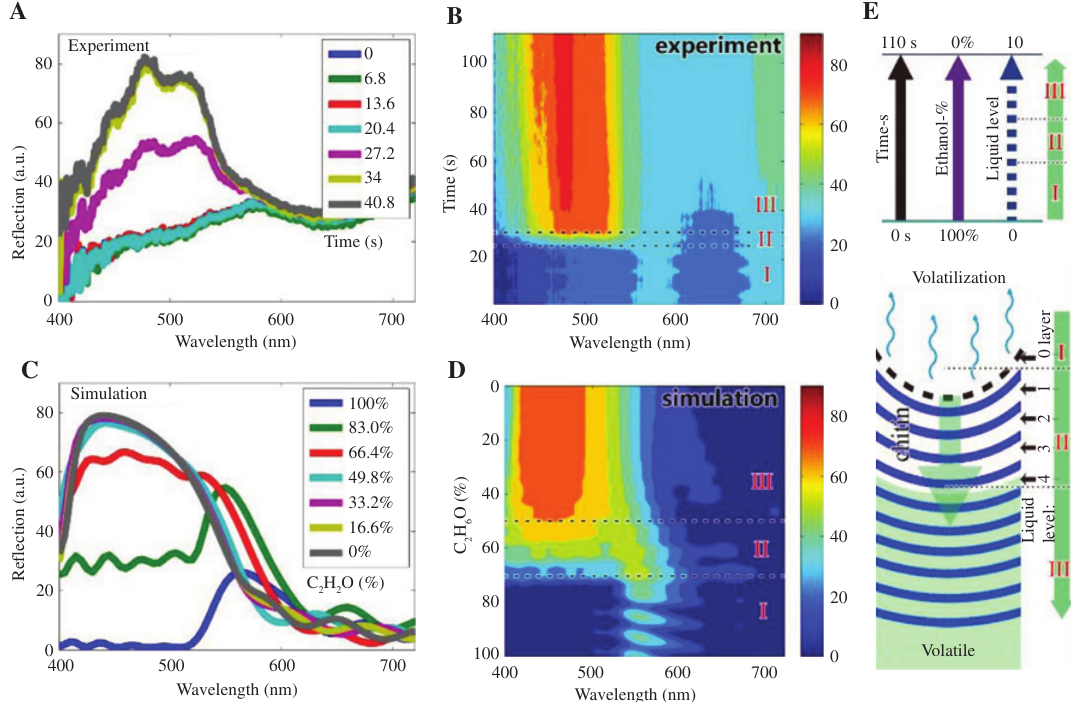
Figure 4: Experiment and simulation reflectance of butterfly wing (not sealed) with the natural vaporization of ethanol show the optical response process. (A, B) Line plot and contour plot of experiment reflectance considered as a function of time, the reflective data tested at 1.7-s intervals. (C, D) Line plot and contour plot of simulation reflectance considered as a function of different quantity of ethanol. (E) Diagram of the ethanol volatilization in periodic concave multilayer, the time of the volatilization is from 0 s to 110 s, the corresponding change of ethanol is from 100% to 0% (in simulation model), and the corresponding liquid level is changed from layer 0 to layer